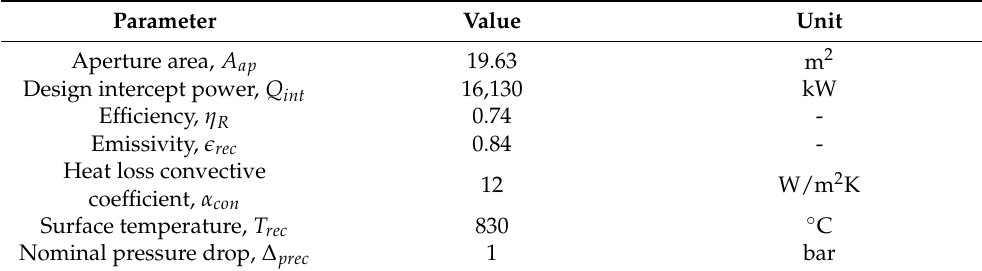
Table 5. Design parameters of the receiver.